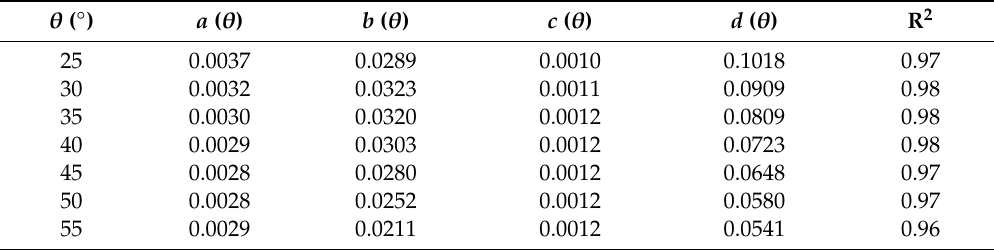
Table 5. Empirical coe ffi cients at di ff erent incidence angles in VV polarization ( Hrms ∈ (0.5, 2.5) cm).